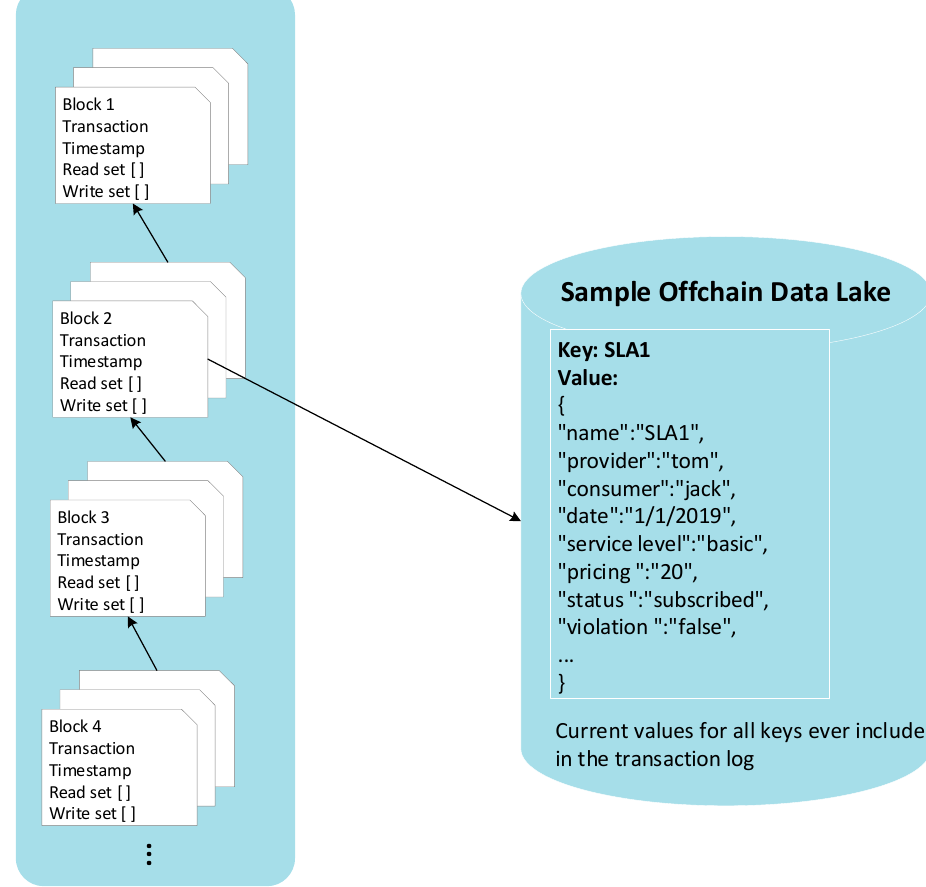
ff -chain data lake in the case